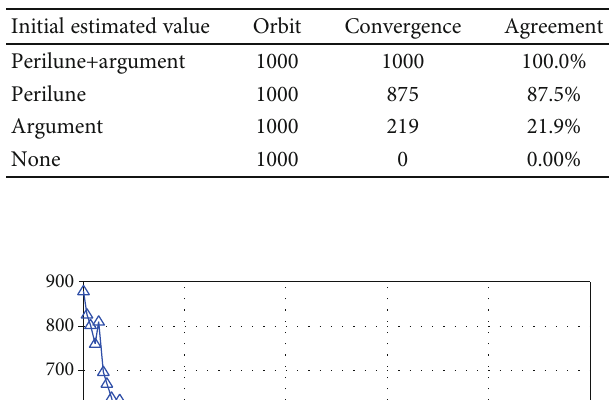
Table 6: Convergence analysis.